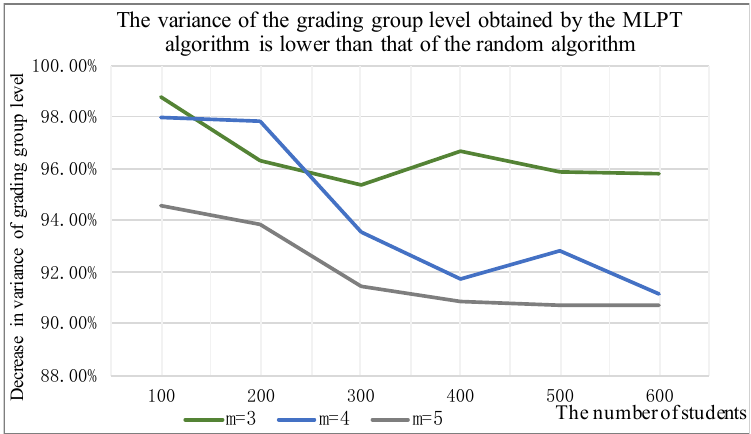
Figure 9. Comparison of experimental results between the MLPT algorithm and the random algo- rithm.